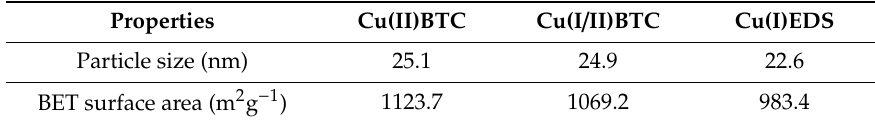
Table 1. Structural properties of synthesized MOFs.